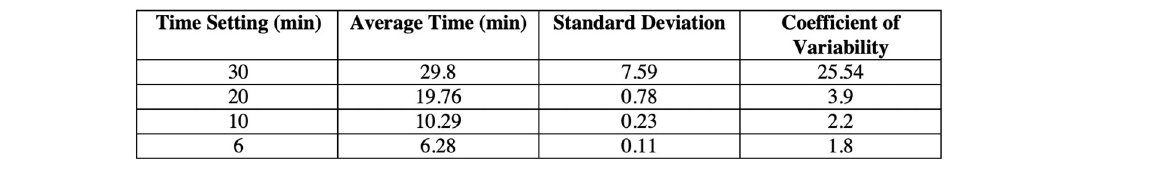
from, the performance is consistent after the